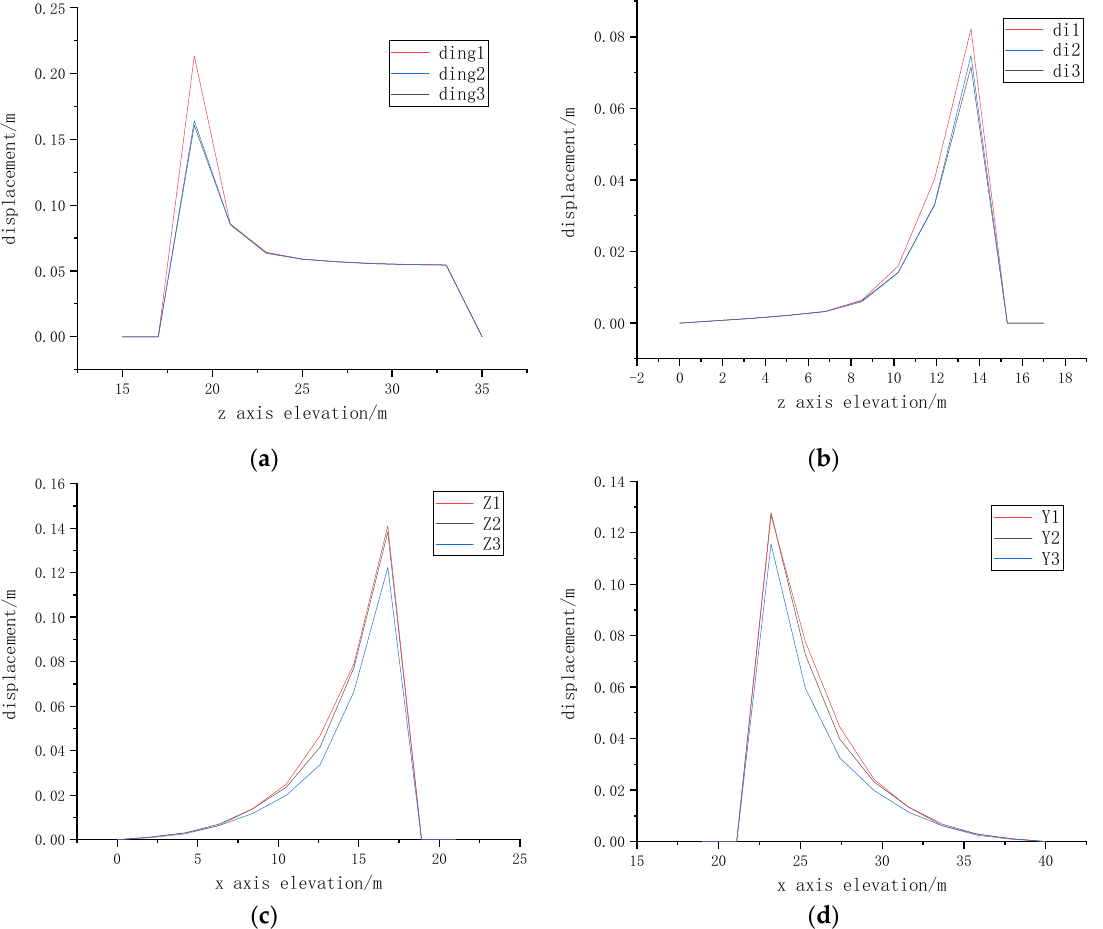
Figure 11. Roadway monitoring point axis elevation-displacement curve. ( a ) Roof monitoring point z axis elevation-displacement curve; ( b ) Floor monitoring point z axis elevation-displacement curve; ( c ) X axis elevation-displacement curve of left side monitoring point; ( d ) X axis elevation-displacement curve of the right side monitoring point.